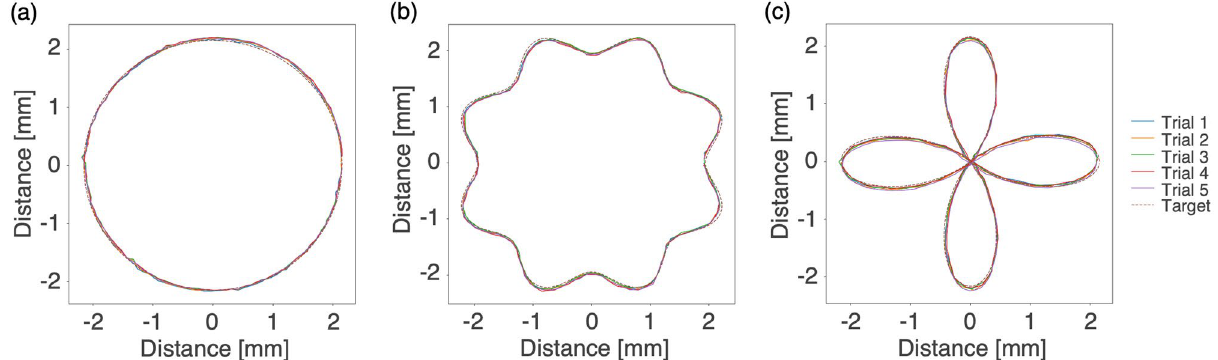
Figure 4. Laser spot trajectories for ( a ) circle, ( b ) wavy circle, and ( c ) four-leaved targets.